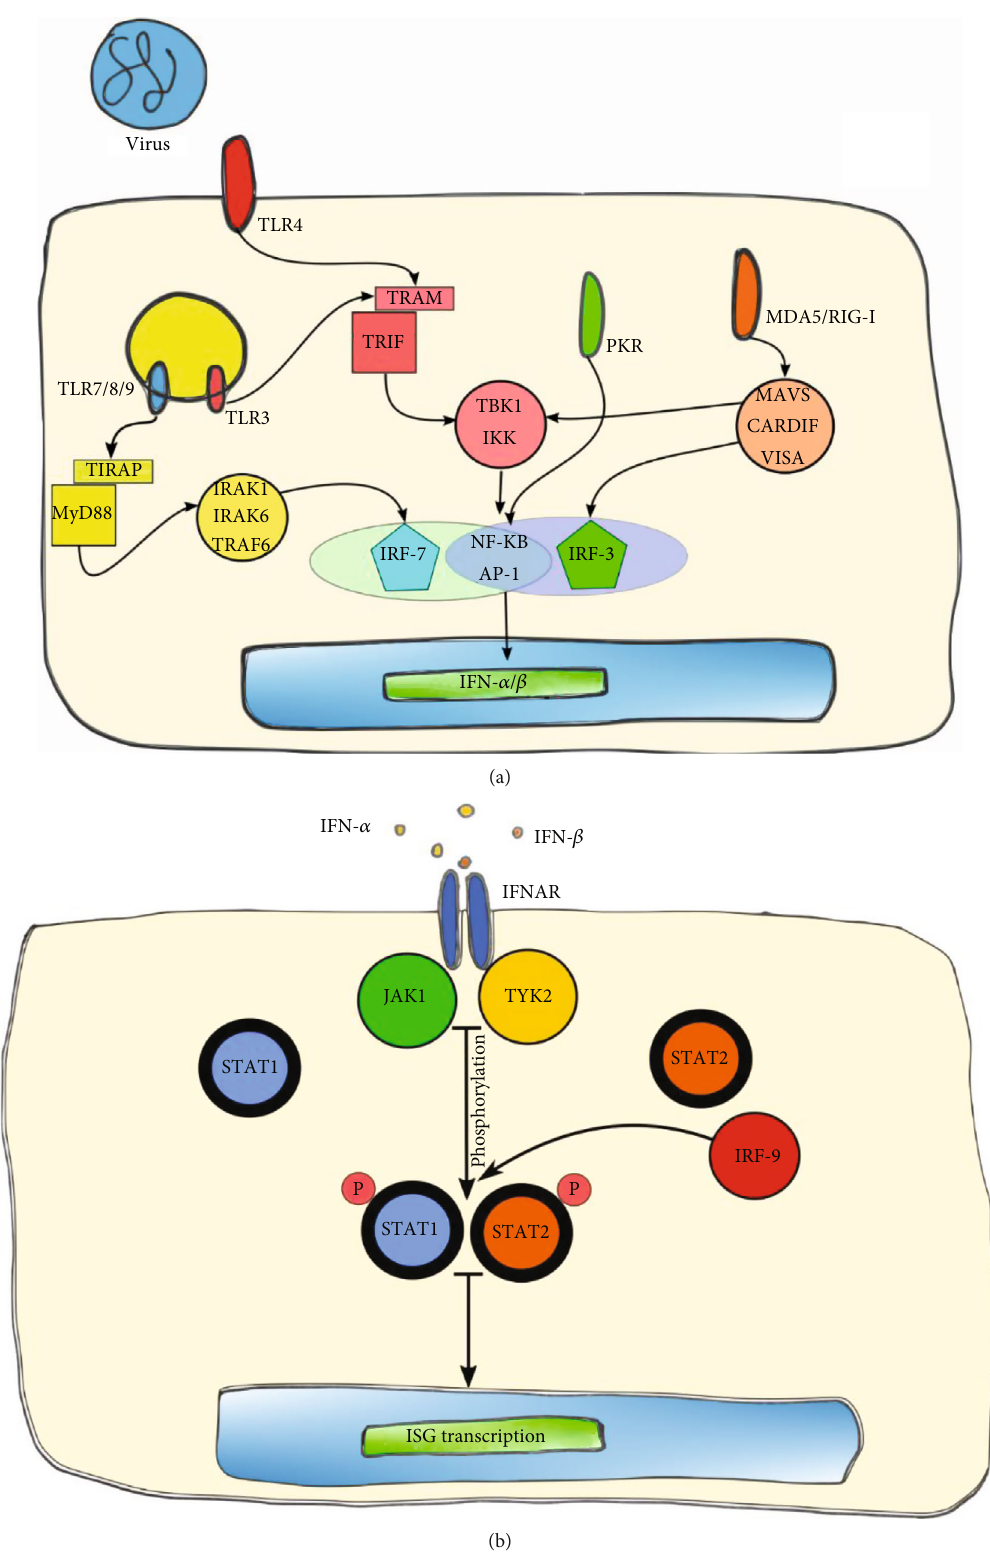
Figure 1: Type I interferon immune response. (a) Detection of viral infection by pathogen recognition receptors and signaling cascades resulting in the production of IFN-I. (b) IFN-I- α / β receptor (IFNAR) and activation of the JAK/STAT pathway leading to the induction of IFN-stimulated